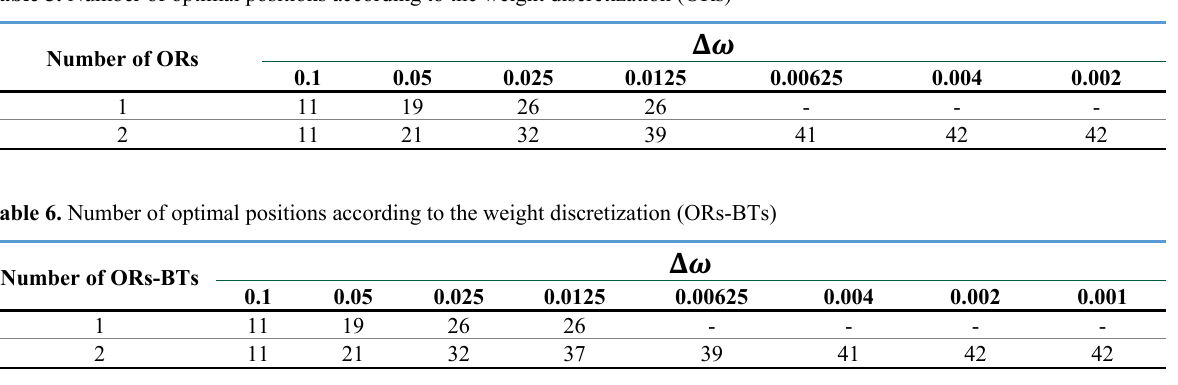
Table 5. Number of optimal positions according to the weight discretization (ORs) Number of ORs